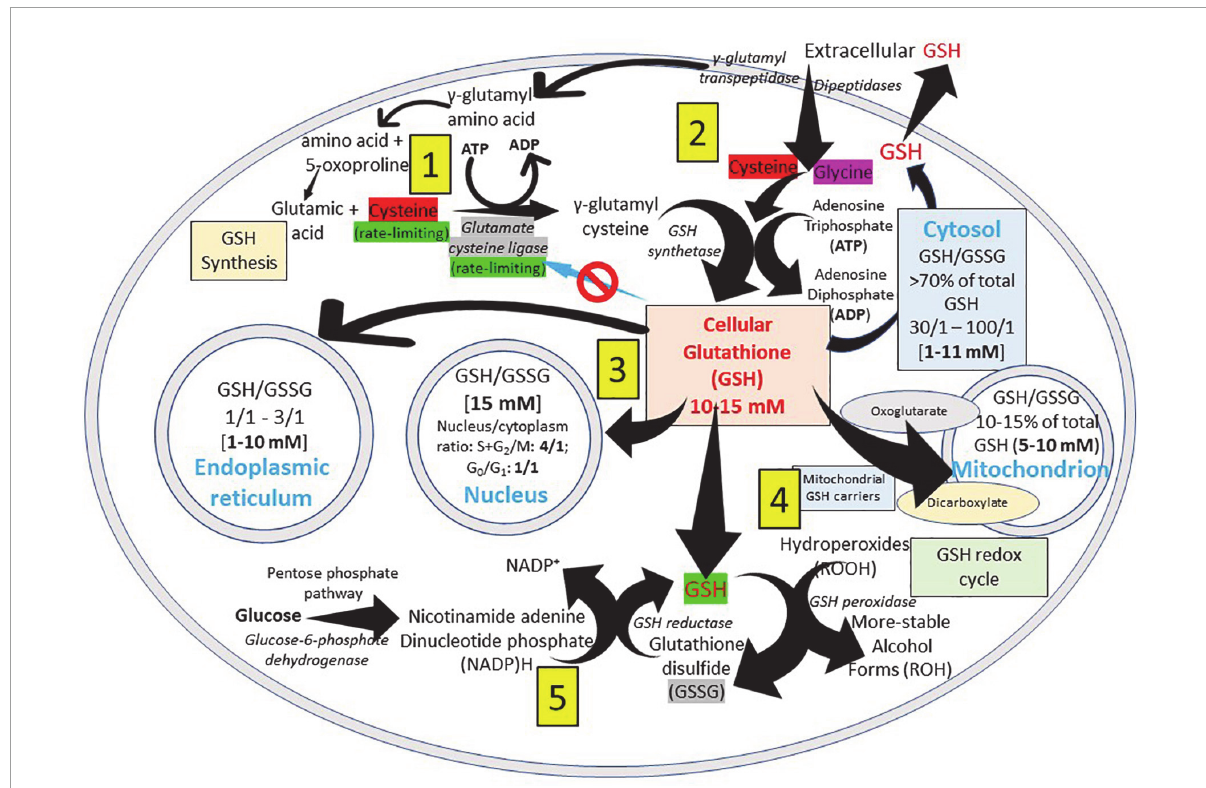
FIGURE2 Glutathione distribution in subcellular compartments. GSH ( γ - L-glutamyl-L-cysteinyl-glycine), a water-soluble tripeptide formed by the amino-acids glutamic acid, cysteine and glycine, is considered the major non-protein low molecular weight modulator of redox processes and the most important thiol reducing agent of the cell. (1) ATP-dependent GSH biosynthesis occurs in the cytosol of the cell and cysteine (red) and glutamate cysteine ligase (gray) are rate-limiting factors for its production. (2) Extracellular GSH is enzymatically degraded on the surface of the cells by γ -glutamyl transpeptidase generating the γ -glutamyl fraction (taken into the cell as γ -glutamyl-amino acid that can be metabolized to release the amino acid and 5-oxoproline, which can then be converted into glutamate to be used in the synthesis of GSH) and the cysteinyl-glycine fraction; and by dipeptidases splitting cysteinyl-glycine generating cysteine and glycine that are taken into the cell. (3) To allow normal cell function, it is essential to maintain an optimal GSH: GSSG ratio throughout all cell compartments. (4) The inner mitochondrial membrane system transport, that involves dicarboxylate and 2-oxoglutarate anion transporters, allows the passage of negatively charged GSH from the cytosol to the mitochondria. (5) GSH is present in both reduced (GSH) and oxidized (GSSG) states, and reduced GSH is maintained by GSH reductase, a cytosolic NADPH-dependent enzyme. GSSG returns to the reduced state by the NADPH-dependent activity of glutathione reductase. NADPH is rapidly regenerated from NADP + using electrons derived from catabolism of substrate molecules, such as glucose or isocitric and malic acid (pentose phosphate pathway). Reduced GSH neutralizes cellular hydroperoxides through GSH peroxidase